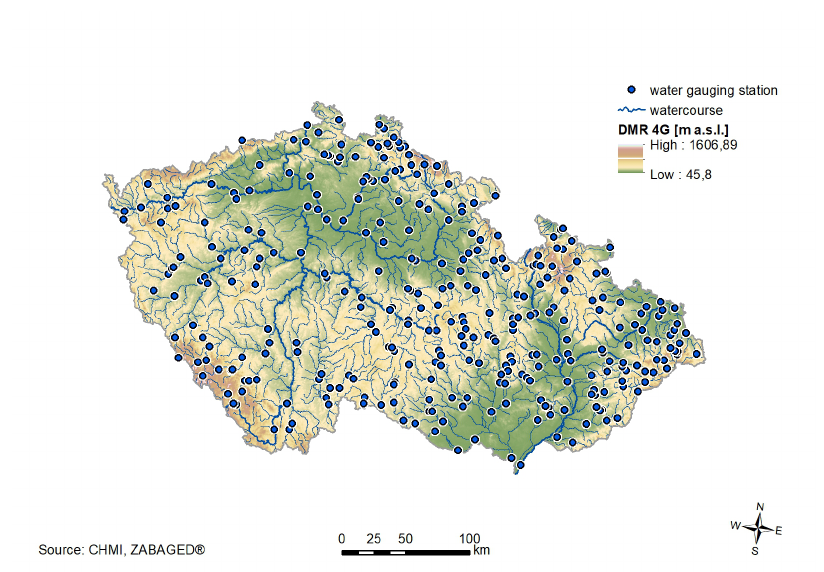
Figure 4. Spatial distribution of gauging stations used to create the